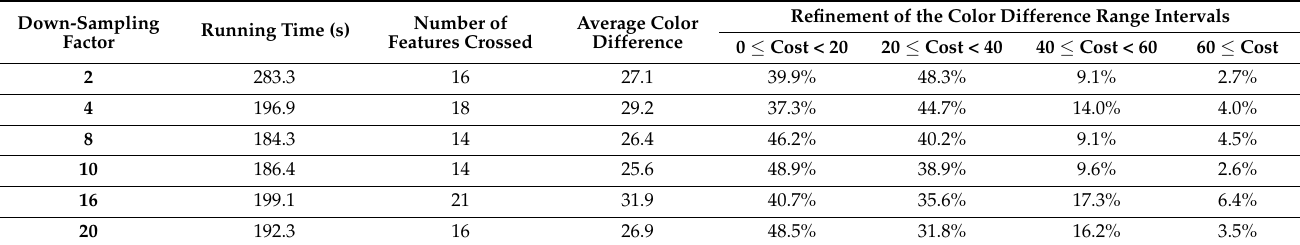
Table 2. Results obtained by selecting different resampling factors for Dataset